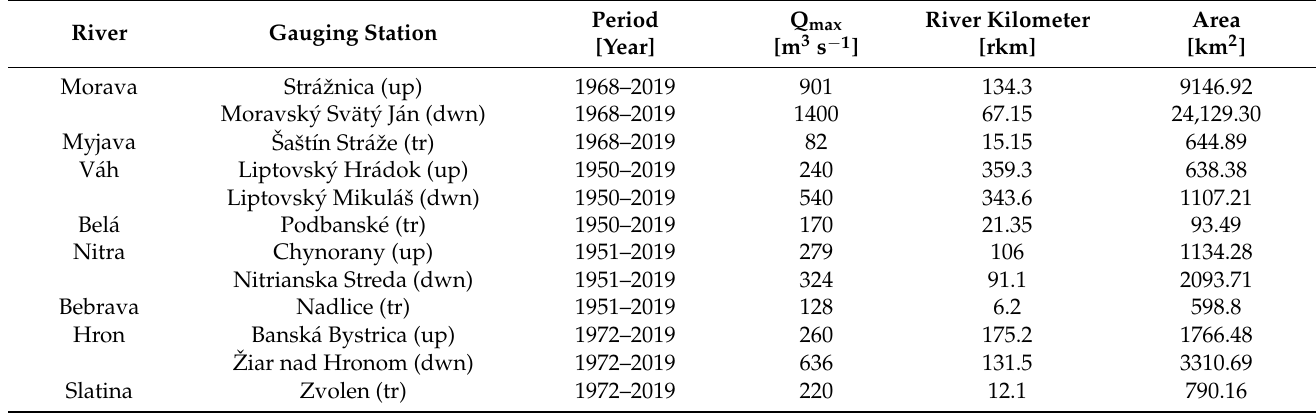
Table 2. Mathematical description of the applied Gumbel–Hougaard copula.